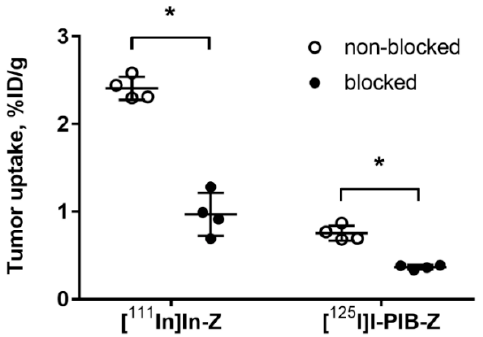
Figure 3. Specificity of [ 125 I]I-PIB-(HE) 3 -Z HER3:08698 -DOTAGA and [ 111 In]In-(HE) 3 -Z HER3:08698 - DOTAGA tumor targeting in Balb / c nu / nu mice bearing BxPC-3 xenografts. The uptake of both imaging probes in tumors was significantly (* p < 0.0001) decreased when a large excess of non-labeled HER3 affibody molecule was administered. Data are presented as average ± SD for four mice. Table 3. Biodistribution of [ 125 I]I-PIB-(HE) 3 -Z HER3:08698 -DOTAGA and [ 111 In]In-(HE) 3 -Z HER3:08698 - DOTAGA in Balb/c nu/nu mice bearing BxPC3 xenografts at 4 and 24 h pi. Uptake is presented as percent of injected dose per gram (%ID/g). Results are presented as average ± SD of four mice.